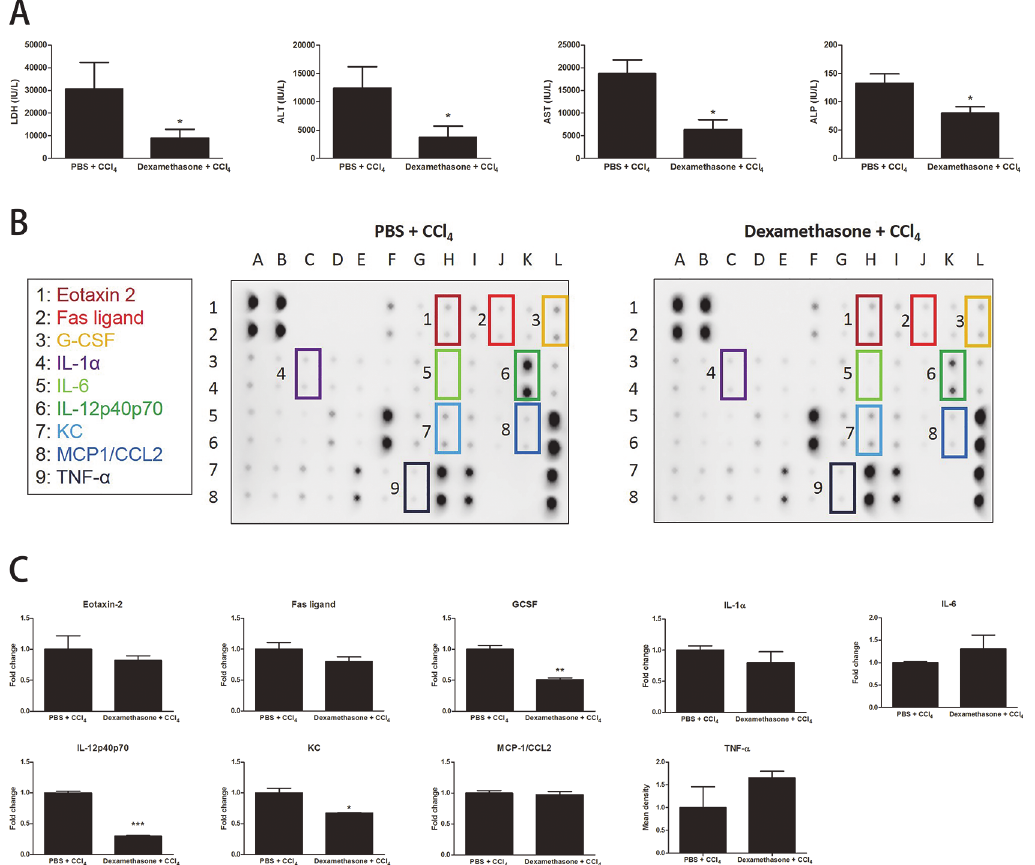
Fig 8. The effect of dexamethasone pretreatment on CCl 4 -induced hepatotoxicity and systemic inflammation. (A) Serum isolated from whole blood was used to determine LDH, ALT, AST, and ALP levels. Bars are means ± SD, n = 4 mice per group. ( * p < 0.05 vs. PBS + CCl 4 ) (B) Inflammation array in serum from PBS + CCl 4 and Dexamethasone + CCl 4 -treated mice. (C) Quantification of the expression of eotaxin-2, FasL, G-CSF, IL-1 α , IL-6, IL-12p40p70, KC, MCP-1/CCL2, and TNF- α in each group. Data are presented as the fold of expression. Bars are mean ± SD for two replicated spots on the membrane. In all figures, significant differences are noted as * p < 0.05 vs. PBS + CCl 4 , ** p < 0.01 vs. PBS + CCl 4 , and *** p < 0.001 vs. PBS + CCl 4